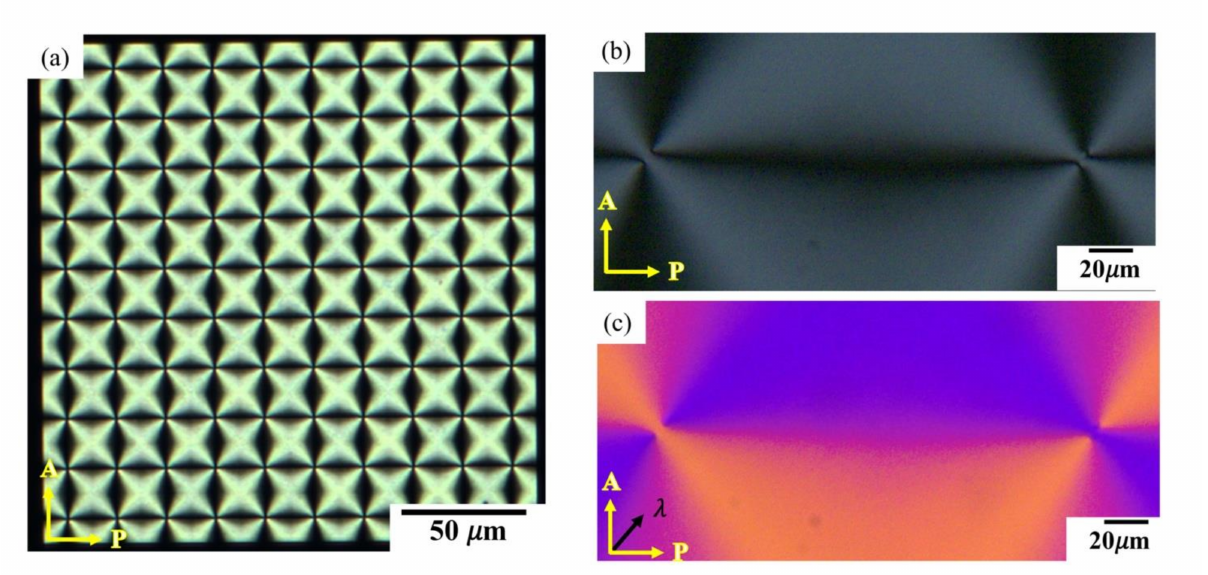
Figure 2. ( a ) Polarizing optical microscope texture of a PPM with ± 1 radial defect array. ( b ) Polarizing optical microscope image of a portion of a photopatterned nematic CCN-47 cell with a +1 radial defect on the left and − 1 defect on the right. The cell thickness 1.09 µ m; irradiation time 4 min. ( c ) Polarizing optical microscope texture of the photopatterned cell in b, with a full-wavelength (530 nm) optical compensator. P, A, and λ represent the polarizer, analyzer, and slow axis of the full-wavelength compensator,